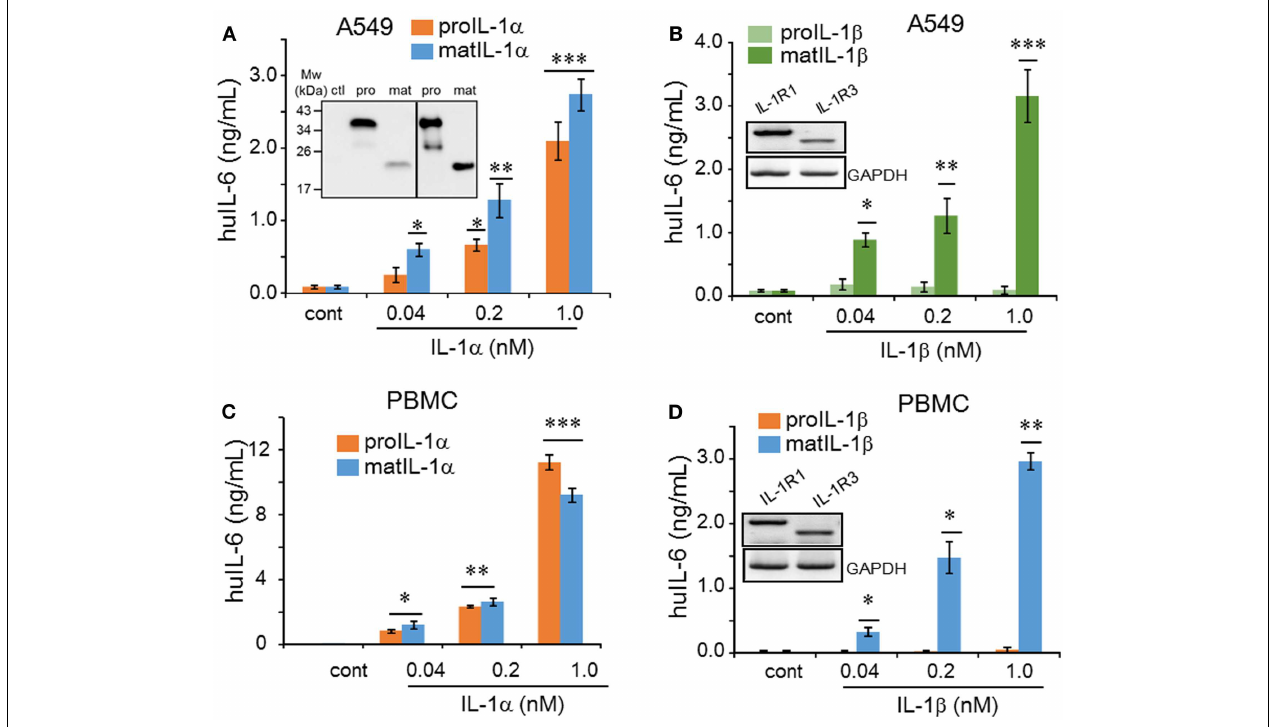
concentrations indicated under the horizontal axis. Inset in (D) shows PCR product of IL-1R1 and IL-1R3 in PBMCs. * p < 0.05; ** p < 0.01; *** p < 0.001 compared to control (cont). RT-PCR products shown are representative of one of two independent experiments. IL-6 data from A549 cells shown are one of two independent experiments performed in triplicate. PBMC data are representative of one of two donors performed in